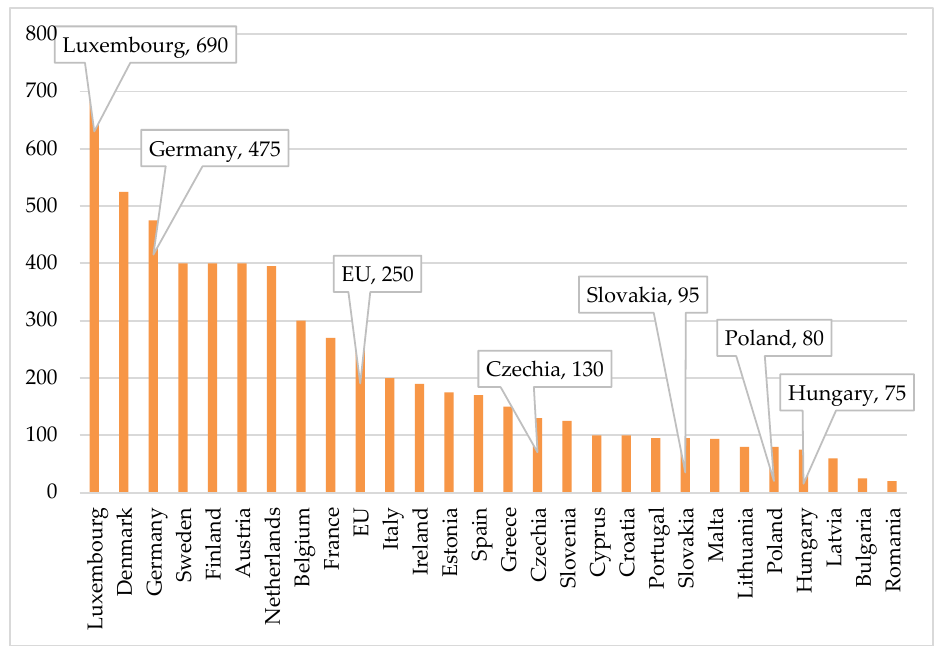
Figure 11. Government budget allocations for R&D (2021, € per person). Source : Adapted from Ref. [77].